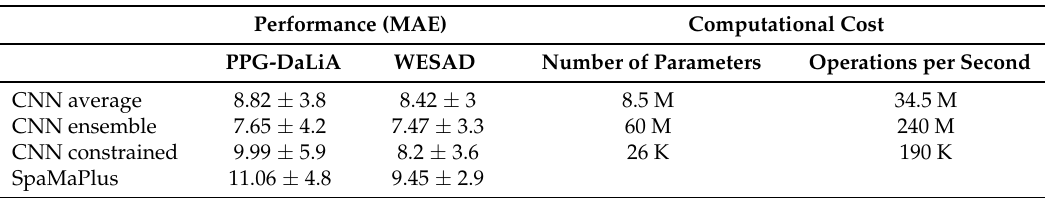
Table 12. Comparison of the large, system-agnostic CNN-models ( CNN average and CNN ensemble ) and the resource-constrained embedded solution ( CNN constrained ). Performance results are given on the two large datasets ( PPG-DaLiA and WESAD ) as MAE [bpm]. Performance of SpaMaPlus shown as reference for best performing classical